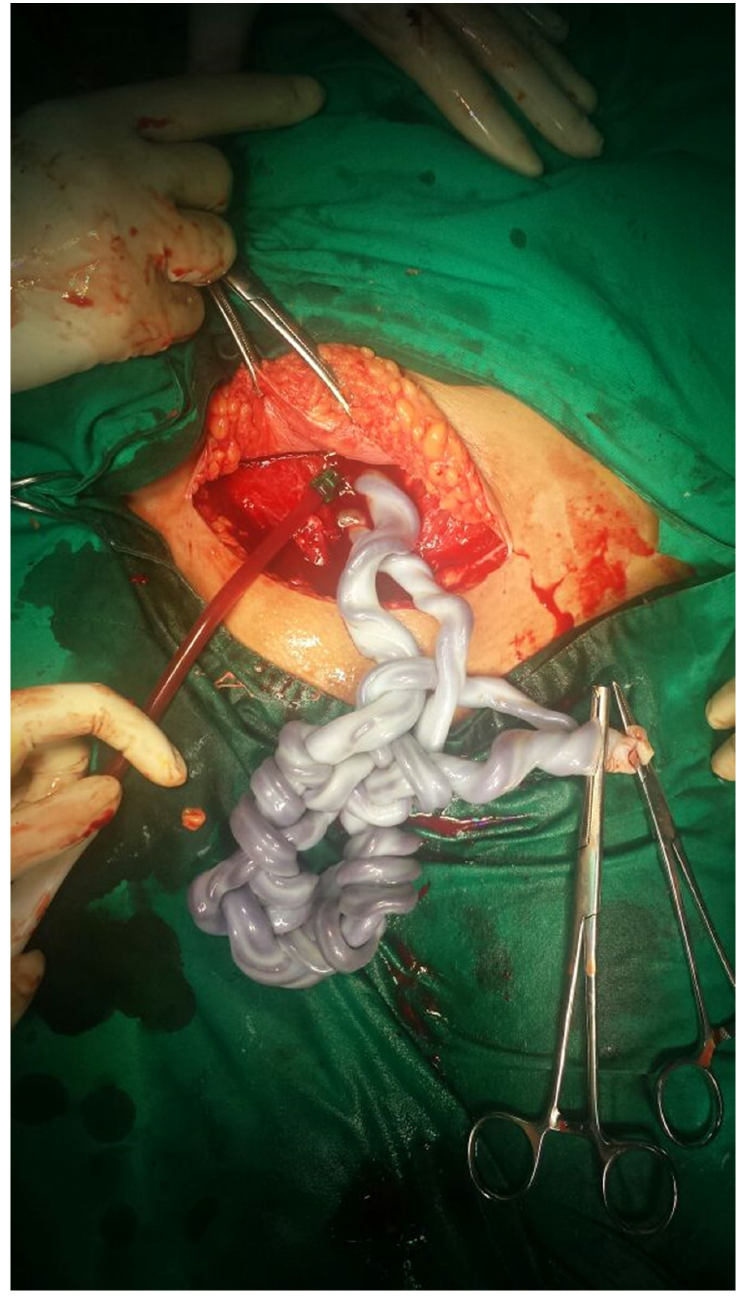
Figure 2. This is a previously unpublished case of a 37-year-old female with major beta-thalassemia (both of her parents were confirmed with minor beta-thalassemia); she was under a protocol of 2 Units RBC transfusions every two weeks; she developed post-transfusion chronic hepatitis C and had a splenectomy performed 5 years prior. She was admitted for secondary amenorrhea which was confirmed to be a spontaneous, monochorionic-monoamniotic twin pregnancy. During pregnancy she had increased liver enzymes three times above the normal limit and maintained a level of haemoglobin above 10 g/dL under protocol of transfusion. Both foetuses had normal development until week 31 when she suffered spontaneous ruptures of membranes. Caesarean section was performed with extraction of the foetuses (pelvic presentation) who were both heathy new-borns. Here is post-extraction capture: the two umbilical cords were wrap around each